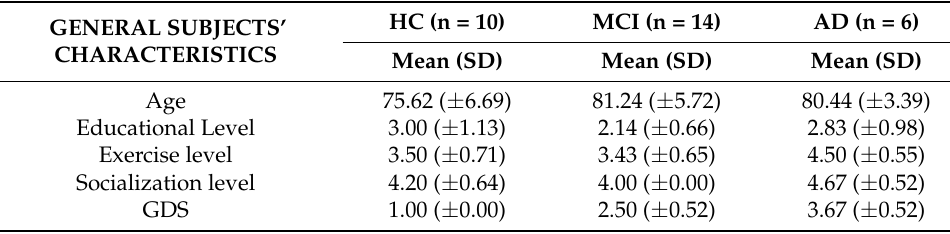
Table 2. Participants’ general and cognitive characteristics by cognitive state.